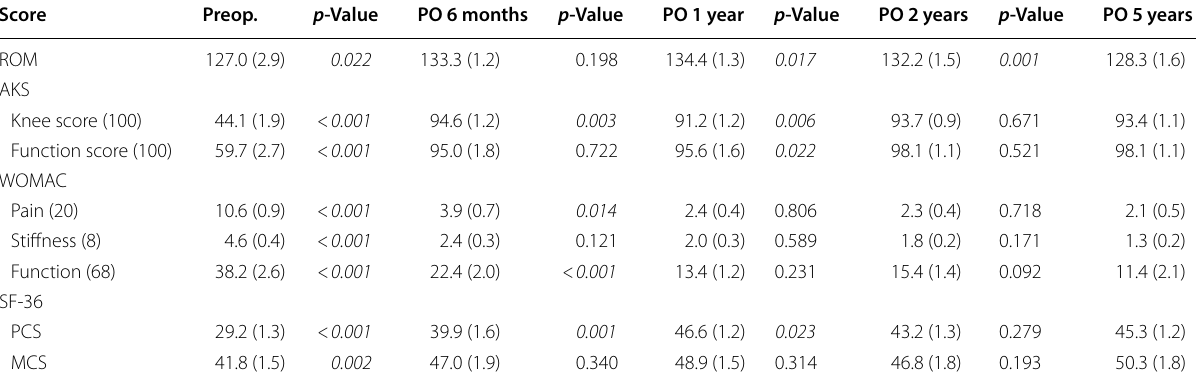
Table 5 Temporal pattern of functional outcome scales in patients aged < 68 years with an MB implant